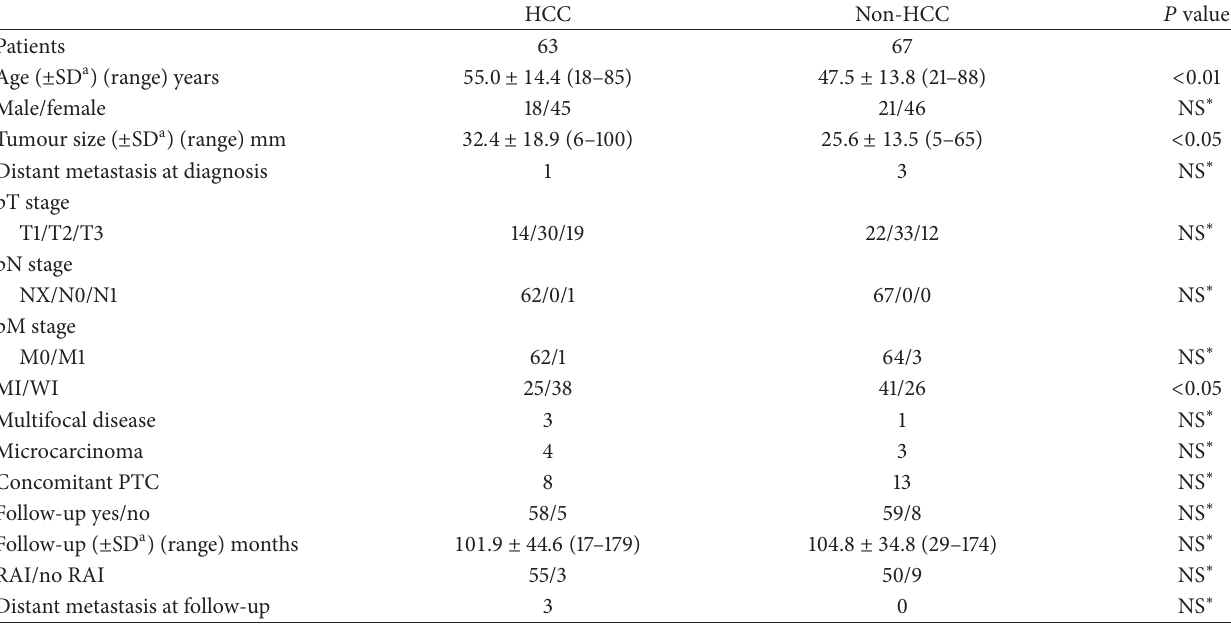
Table 2: HCC versus non-HCC patients: clinical, pathological, and follow-up characteristics.